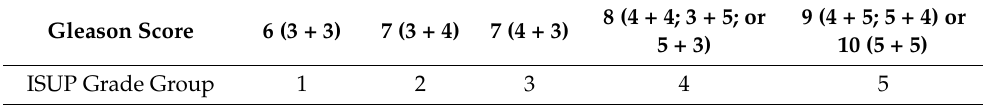
8 (4 + 4; 3 + 5; or 9 (4 + 5; 5 + 4) or 5 + 3) 10 (5 + 5)